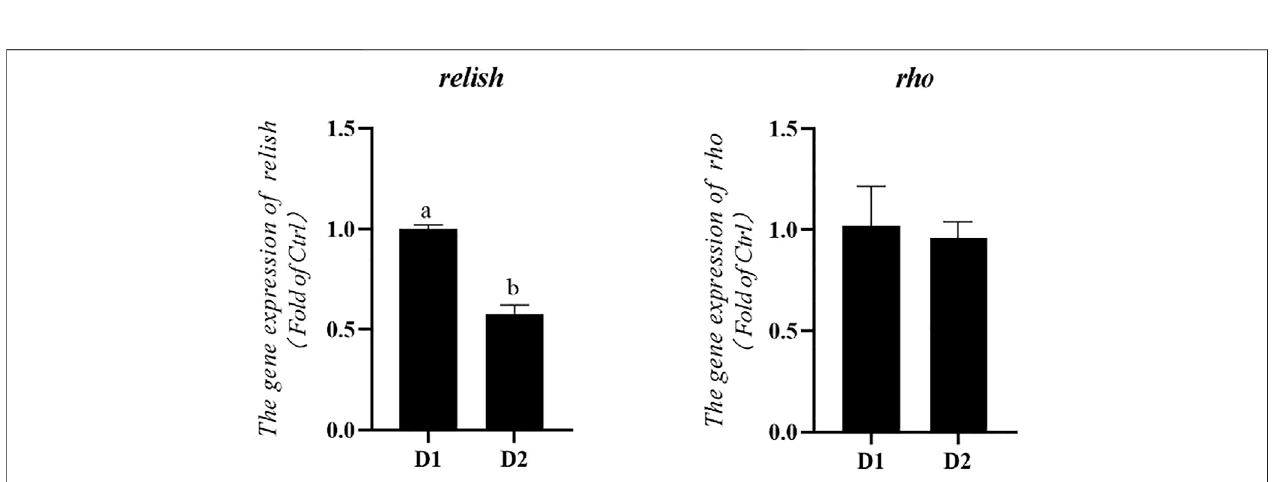
FIGURE2| Hepatopancreas mRNAlevelsofanti-in fl ammatorygenesof L.vannamei feddietsupplementedwith/without H.pluvialis GXU-A23for56 days.Values are mean ± SE ( n = 4). The small letters indicated signi fi cant differences at p < 0.05.